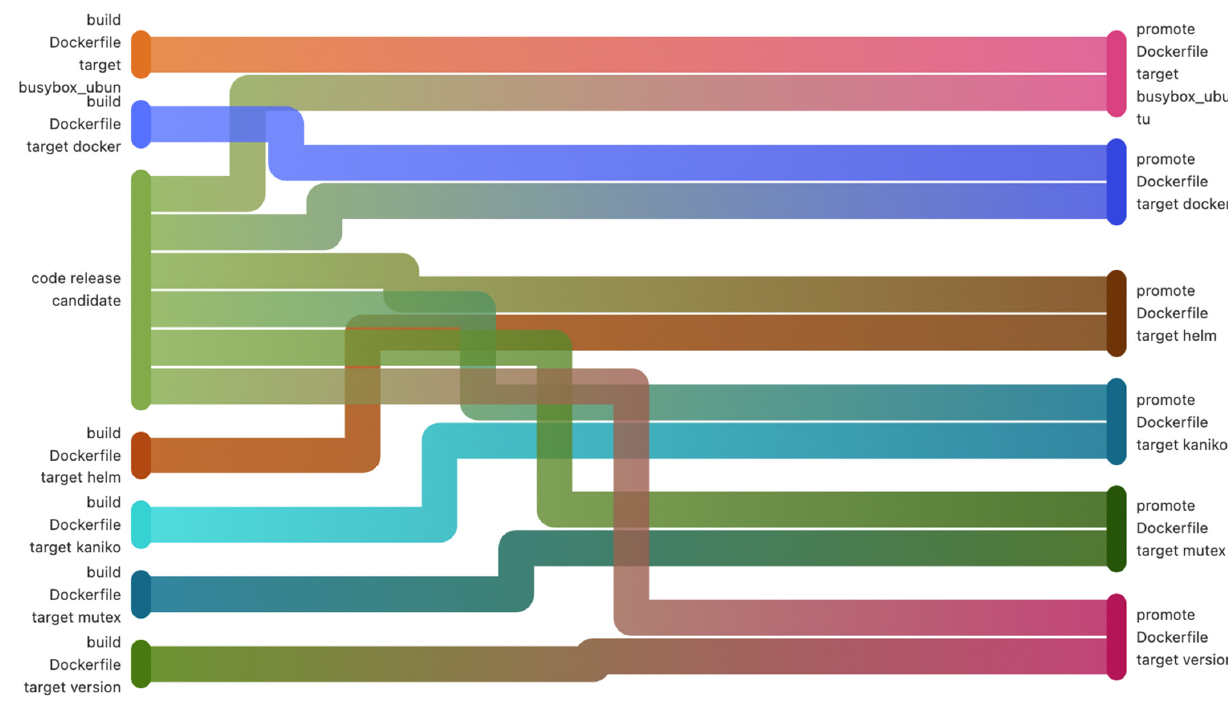
Figure 6. Pipeline diagram flow.